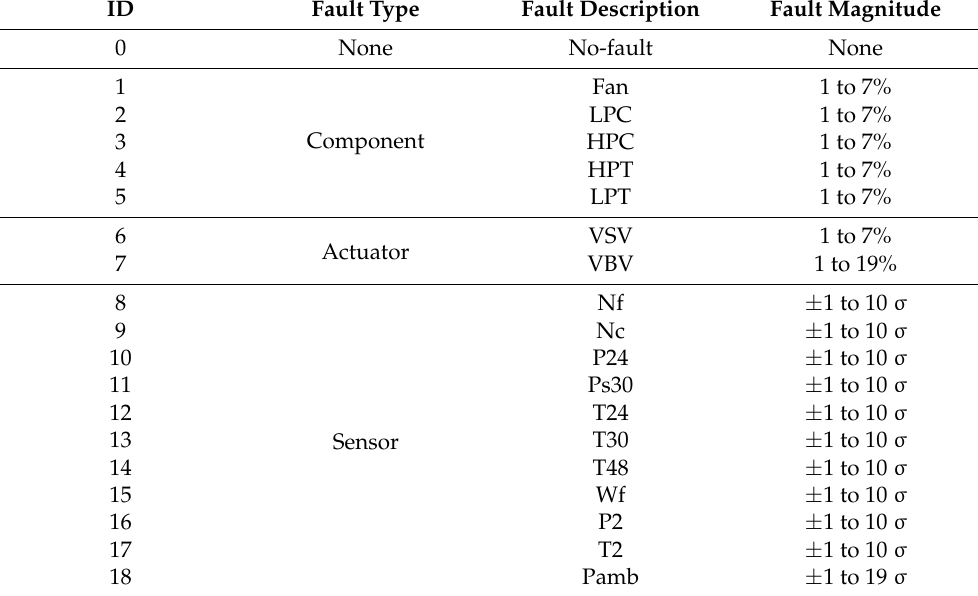
Table 1. Simulated faults in ProDiMES [20].